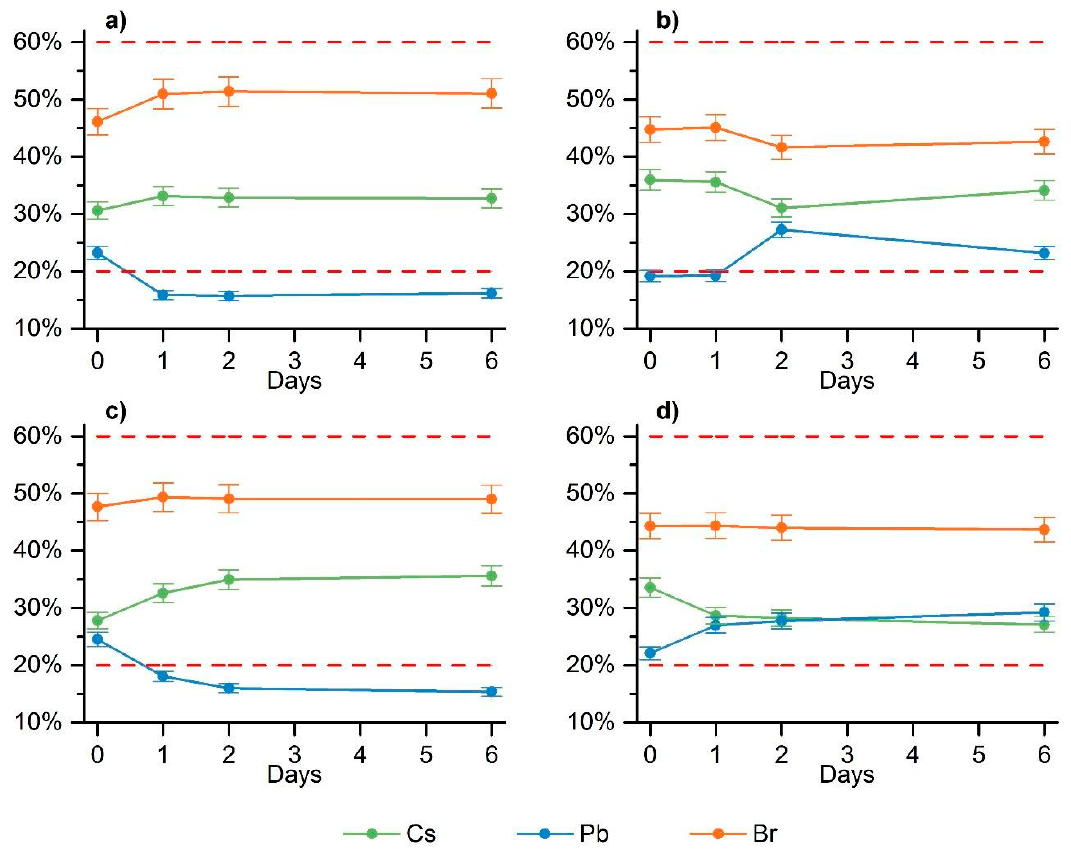
Figure 7. Compositional trends of the perovskite component as a function of exposure time for different substrates: ( a ) silica glass, ( b ) ITO, ( c ) soda-lime glass, and ( d ) gold. The red dashed lines at 20% and 60% represent the theoretical amounts of cesium and lead and of bromine, respectively, in CsPbBr 3 .